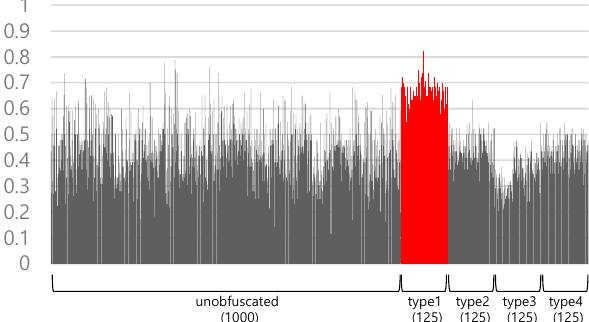
Figure 3. Structure similarity of data compared with obfuscation type 1 with a conventional AST.